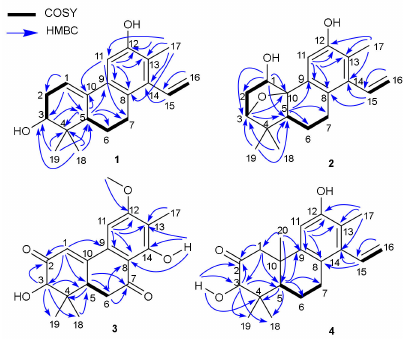
Figure 2. Selected 1 H- 1 H COSY and HMBC correlations of compounds 1 – 4 .